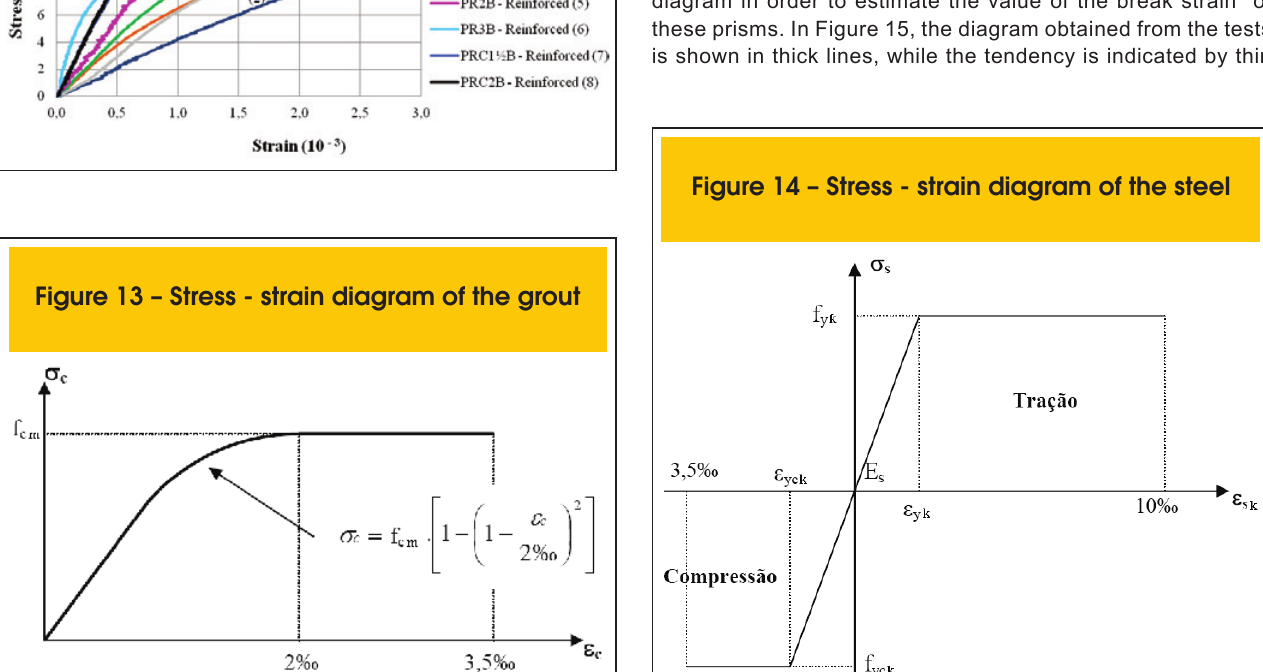
Figure 13 – Stress - strain diagram of the grout